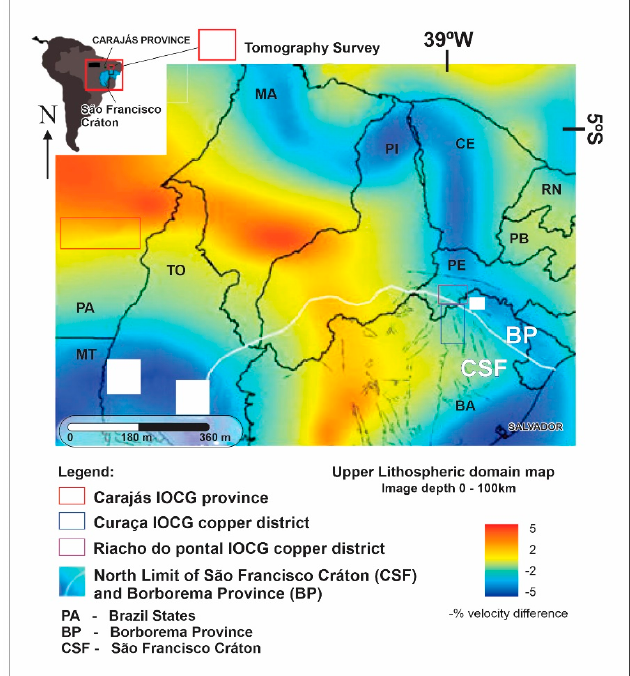
Figure 8. Tomographic image representing seismic S-wave velocity (Vs) of the Carajás IOCG province, Riacho do Pontal and Vale do Curaçá copper districts in Brazil [63–65]. The figure shows a 0–100-km tomographic depth slice. Red to orange colors denote high S-wave velocities (Vs), and blue-green colors denote low Vs values.